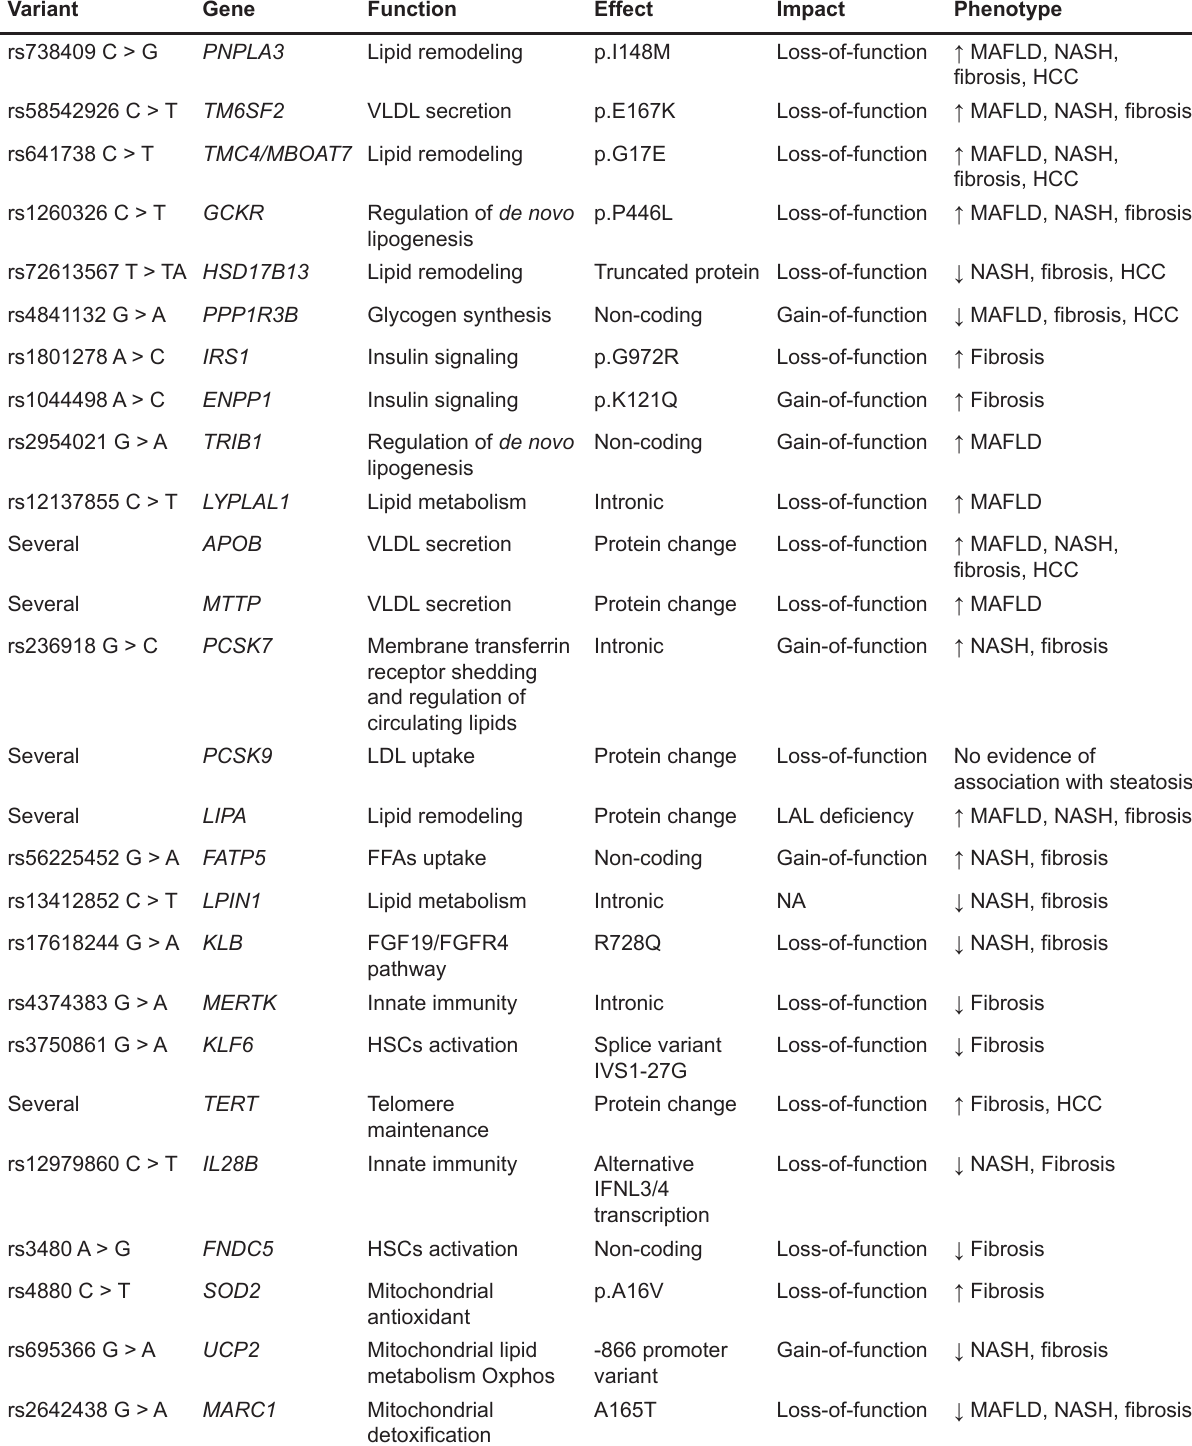
Table 1. List of the main genetic variants associated with the histological spectrum of MAFLD